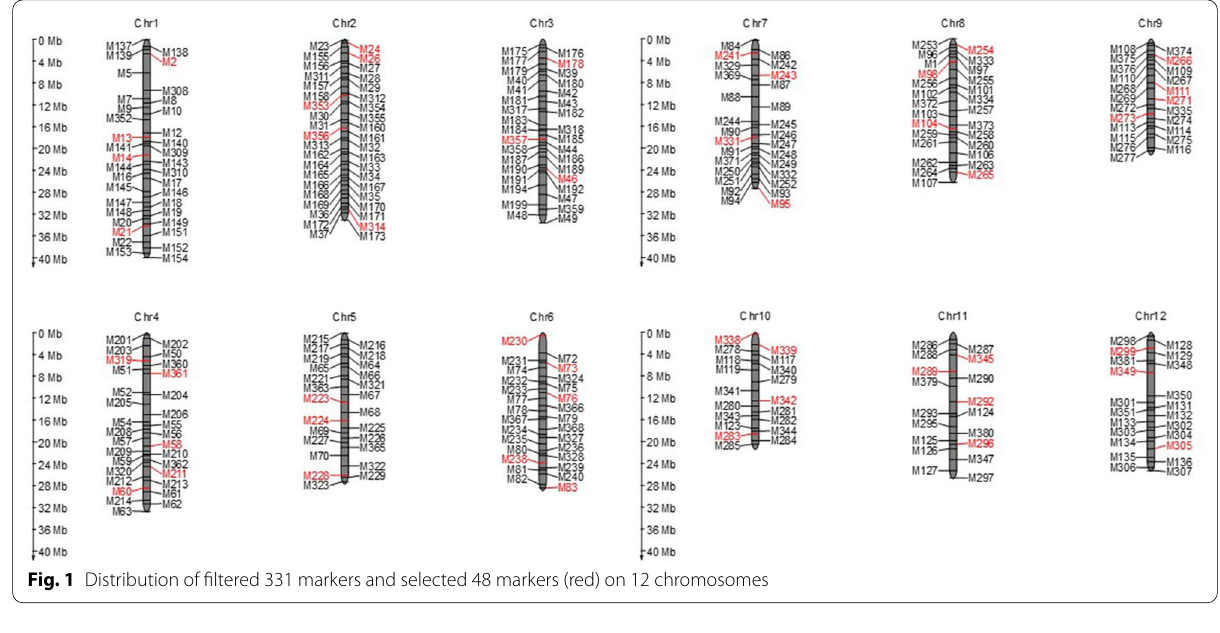
Fig. 1 Distribution of filtered 331 markers and selected 48 markers (red) on 12 chromosomes